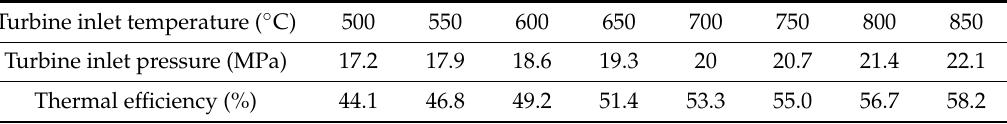
Table 2. Turbine inlet pressures at different turbine inlet temperatures for maximum thermal efficiency of the RBC-PC with improved heat regeneration